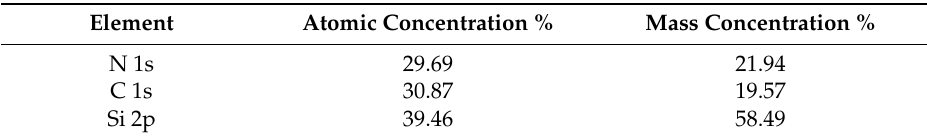
Table 1. Element composition analysis of SiCN film.